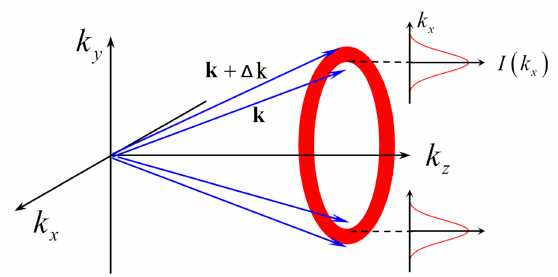
Figure 12. Scheme of the distribution of the light flux over the angular spectrum in the Bessel–Gauss beam.